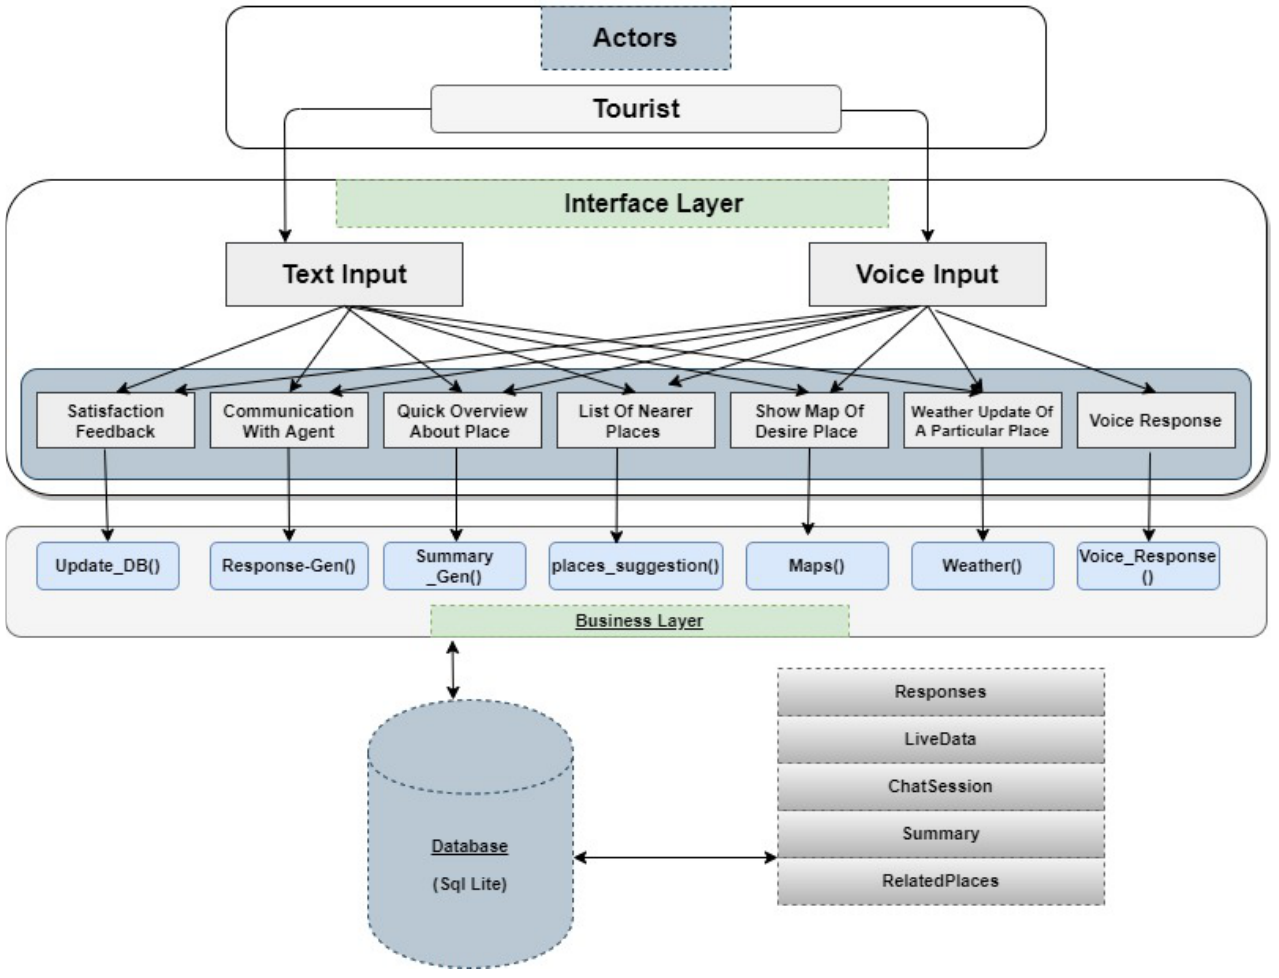
Fig. 2. Architecture of the